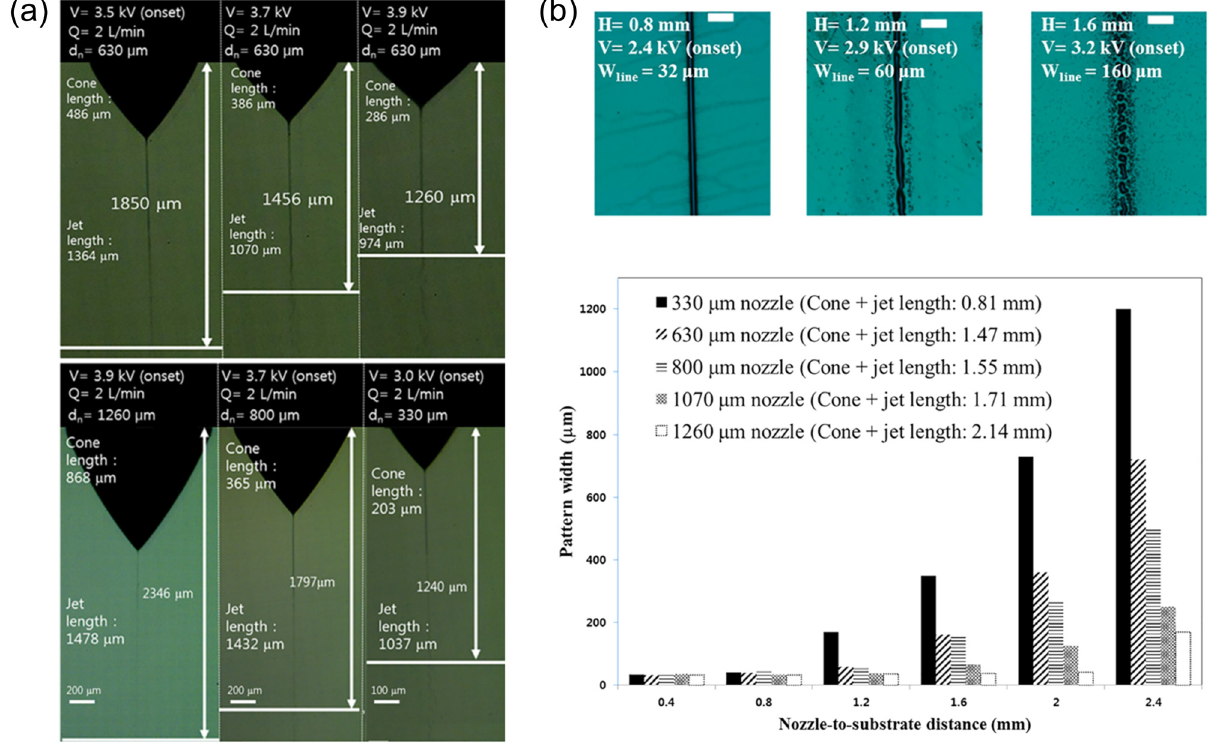
Figure 5: ( a ) Cone and jet length change graph for di ff erent voltages, nozzle sizes and fl ow rates. ( b ) Line images of di ff erent nozzle to substrate distances. Reproduced from ref. [ 79 ] with permission from American Institute of